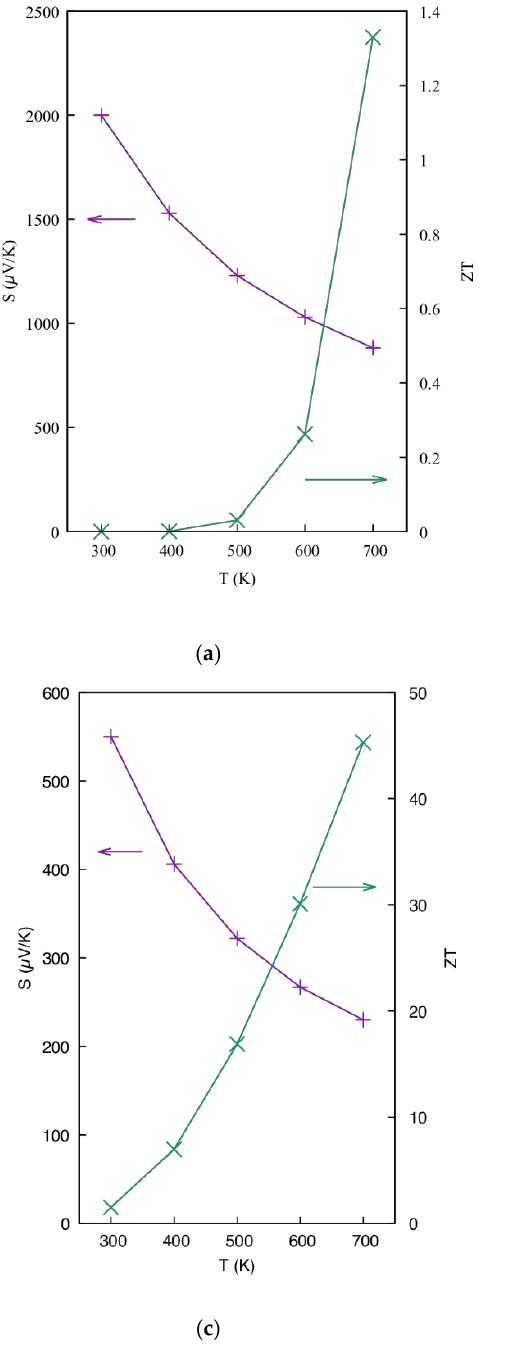
Figure 5. Maximum Seebeck S coefficient and figure of merit ZT with respect to temperature. ( a ) BaRh 2 Ge 4 S 6 ; ( b ) BaRh 2 Ge 4 Se 6 ; ( c ) BaRh 2 Ge 4 Te 6 .